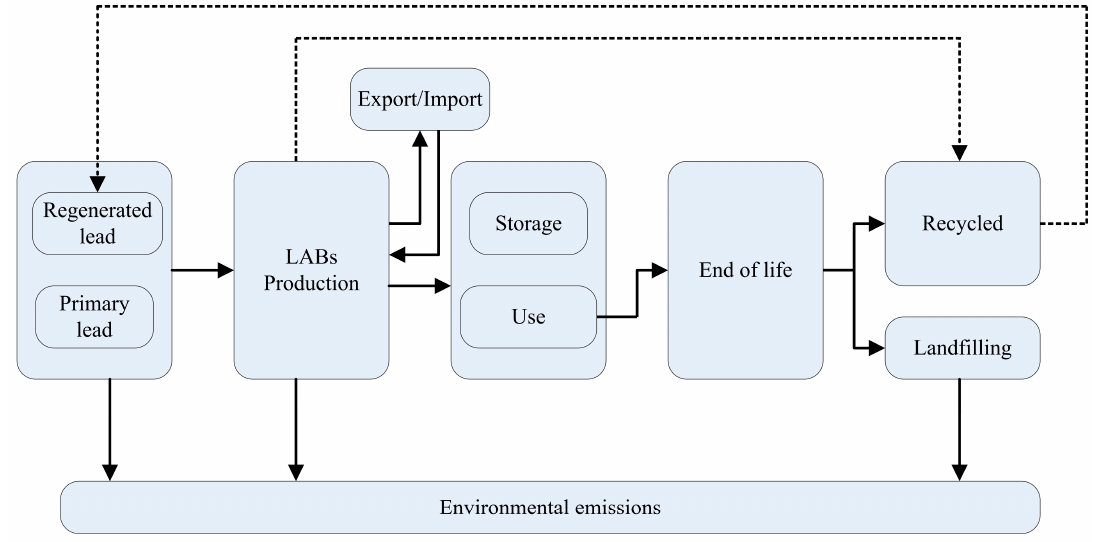
Figure 1. The model for the lead flows of LABs (note: solid lines represent input and output flows; dotted lines represent circular flows).